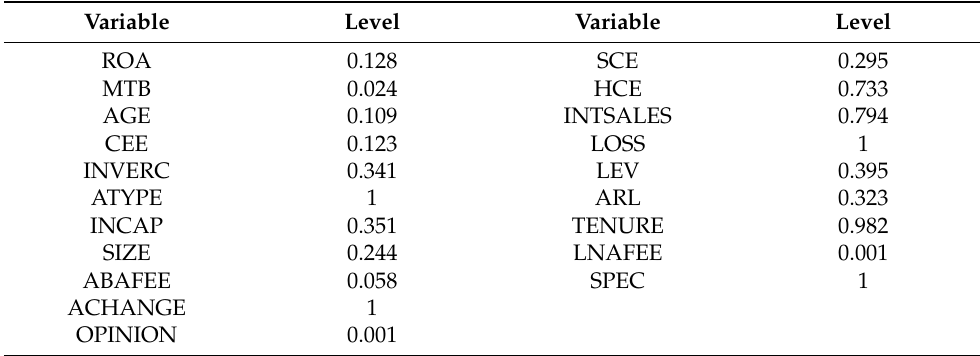
Table A1. The test results for the normality of variables.